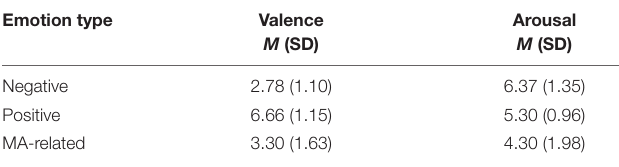
TABLE 2 | The SAM ratings of emotional